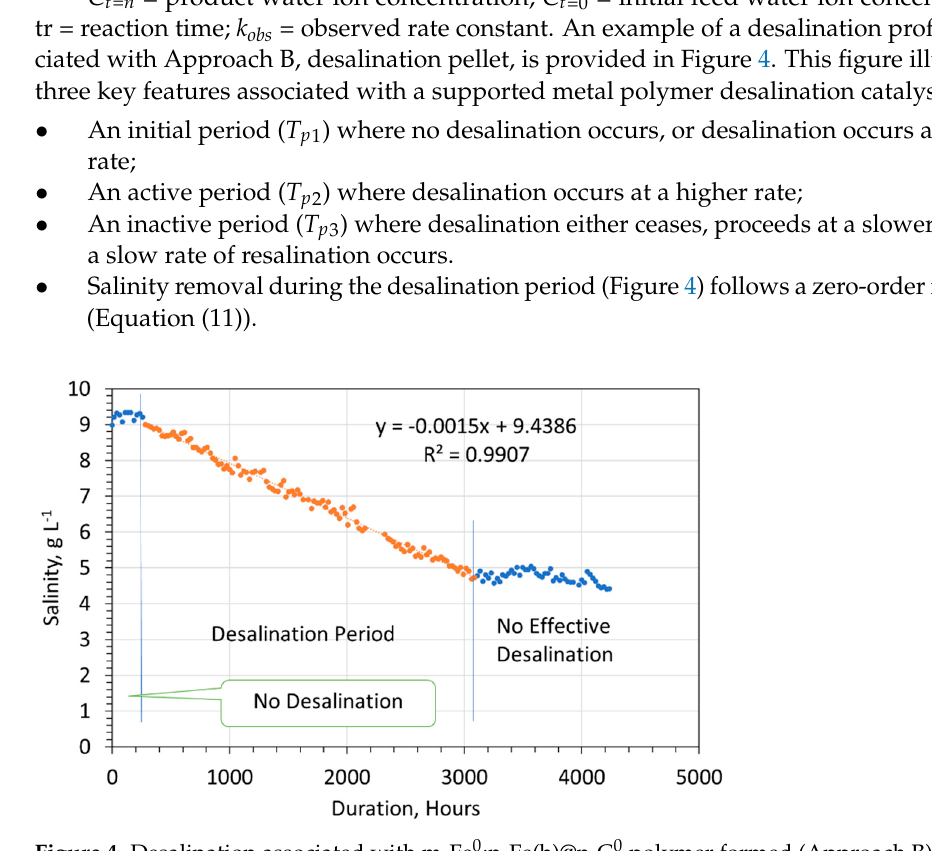
Figure 4. Desalination associated with m-Fe 0 :n-Fe(b)@n-C 0 polymer formed (Approach B) by man- ufacturing the n-C 0 in a Halite Reactor prior to passing it into a bubble column diffusion reactor containing ZVI. Reactor size = 1 L. Pellet weight 75 g m-Fe 0 :n-Fe(b)@n-C 0 polymer L − 1 . The blue and orange coloring is used to distinguish the different stages during desalination.